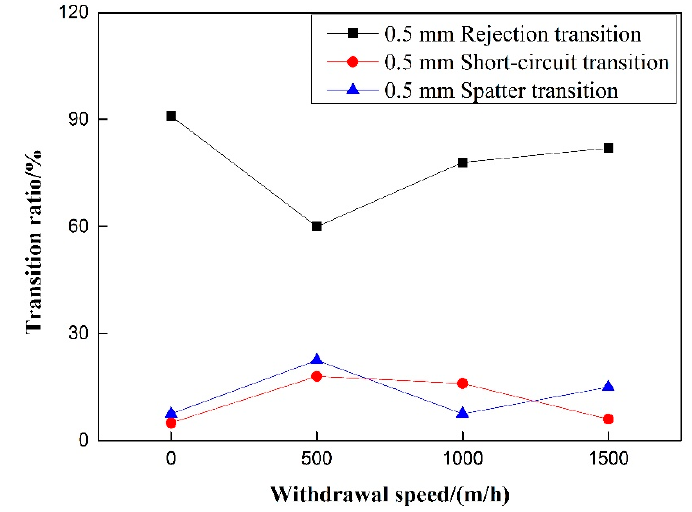
Figure 16. E ff ect of withdrawal speed on transition ratio under 0.5 mm withdrawal Figure 16. Effect of withdrawal speed on transition ratio under 0.5 mm withdrawal quantity.